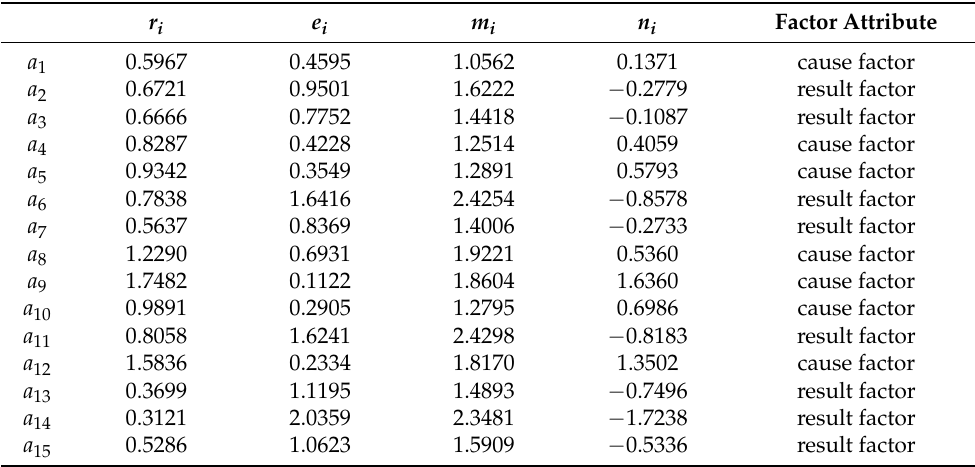
Table 4. The center degree and cause degree of all factors.